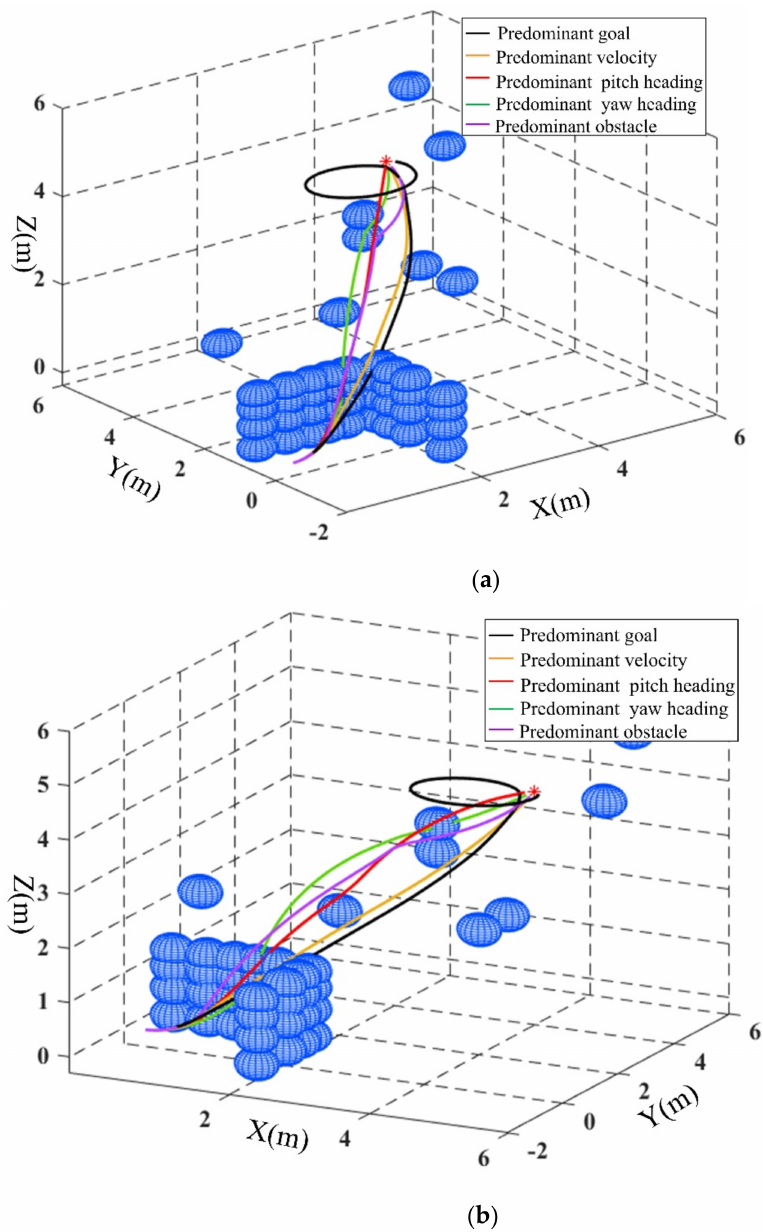
Figure 8. The path planning results with each reward value of the evaluation function being set to predominant weight: ( a ) front view ( b ) side